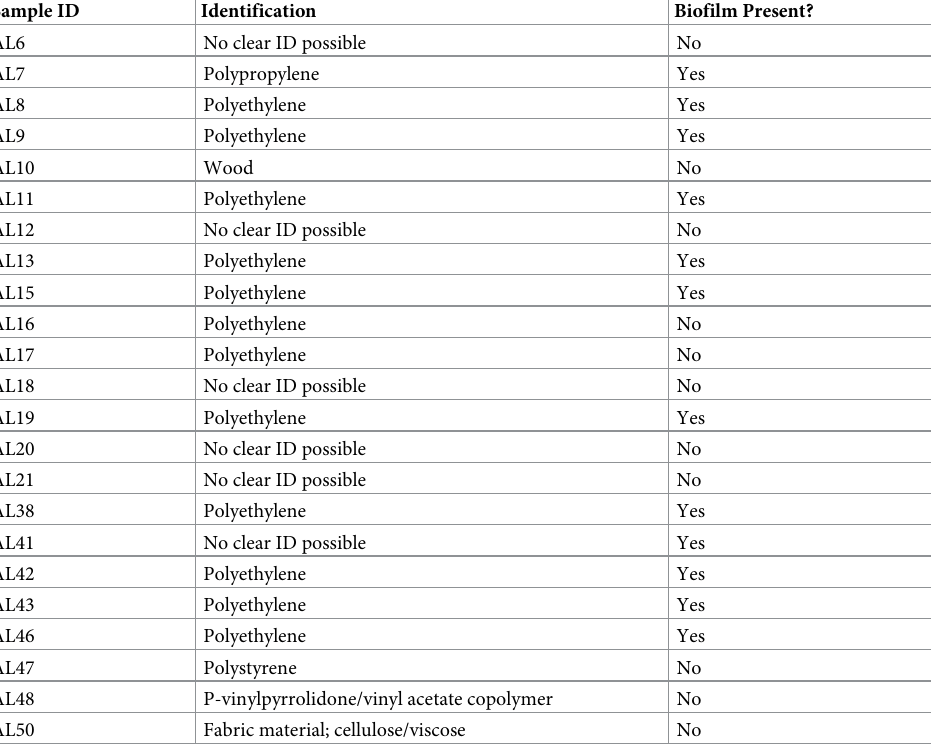
Table 1. Identification of 23 putative microplastic pieces using